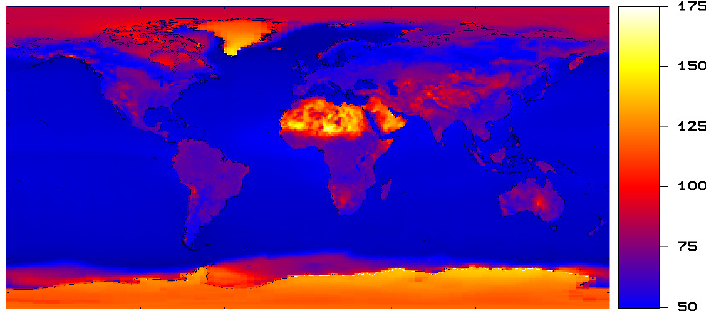
Figure 2. 2000–2018 mean clear-sky CERES RSR. The scale is in W/m 2 .